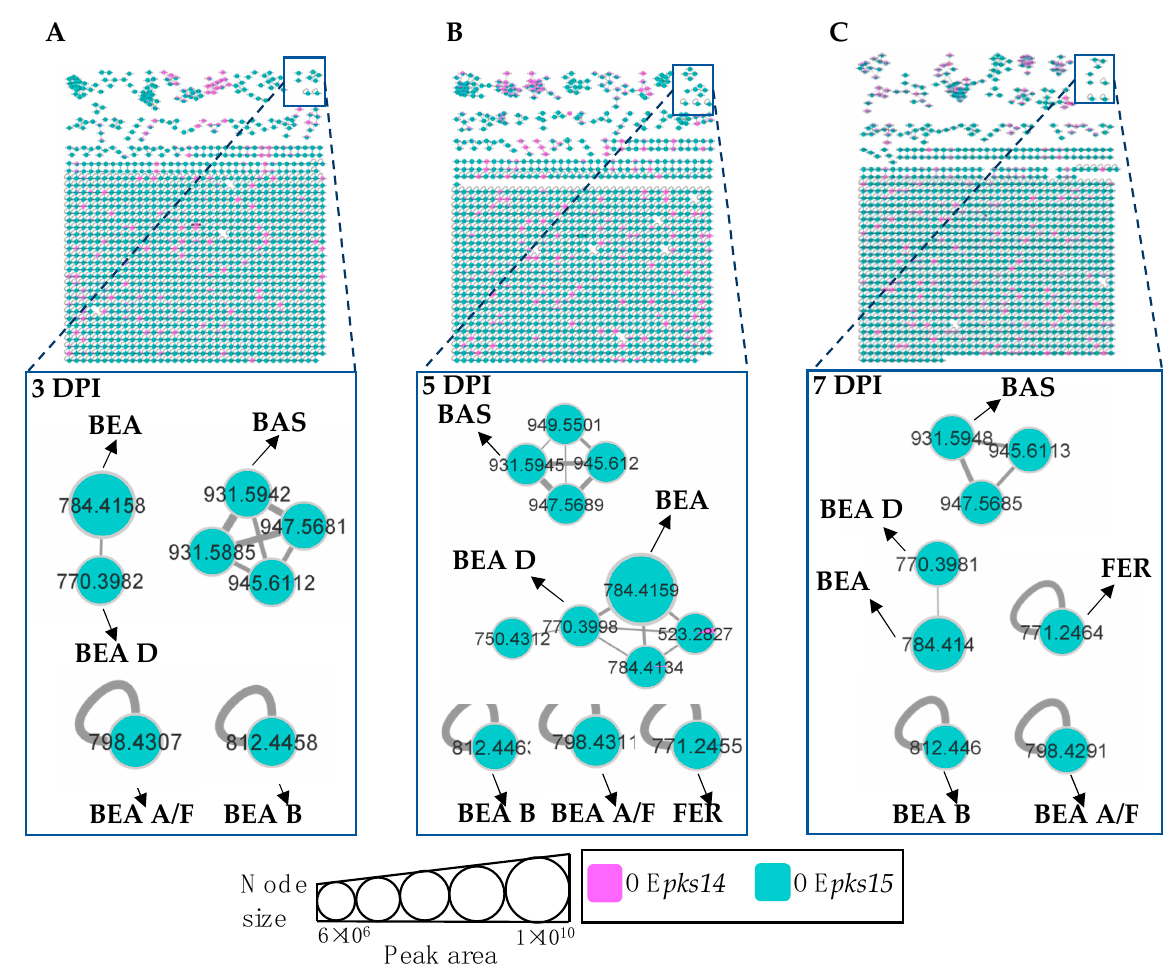
Figure 7. Molecular networking of insect-virulence metabolites and a siderophore for OE pks14 (pink) and OE pks15 (green) strains in vivo at ( A ) early-stage infection (3 DPI) for live larvae, ( B ) mid-stage infection (5 DPI) for dead larvae, and ( C ) late-stage infection (7 DPI) for cadavers covered with fungal hyphae identified beauvericin (BEA), beauvericin A/F (BEA A/F), beauvericin B (BEA B), beauvericin D (BEA D), bassianolide (BAS), and ferricrocin (FER) exclusively from OE pks15 . Node sizes represent the sums of chromatographic peak areas, and pie charts indicate chromatographic peak area-proportions for the detected insect virulence factors.